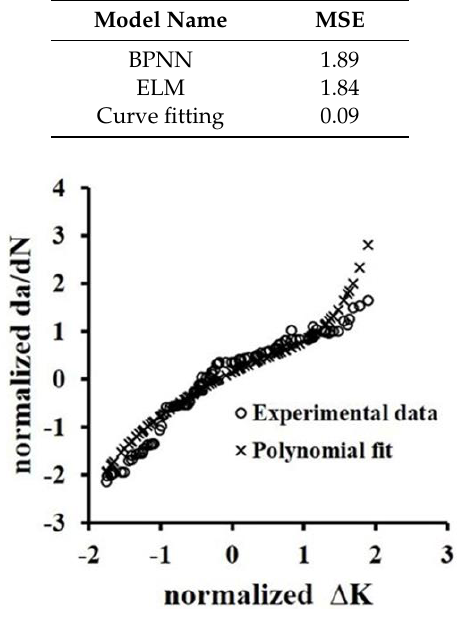
Figure 7. Polynomial curve fit. Table 1. Mean square error (MSE) of machine learning (ML) algorithms compared with polynomial curve fit method.